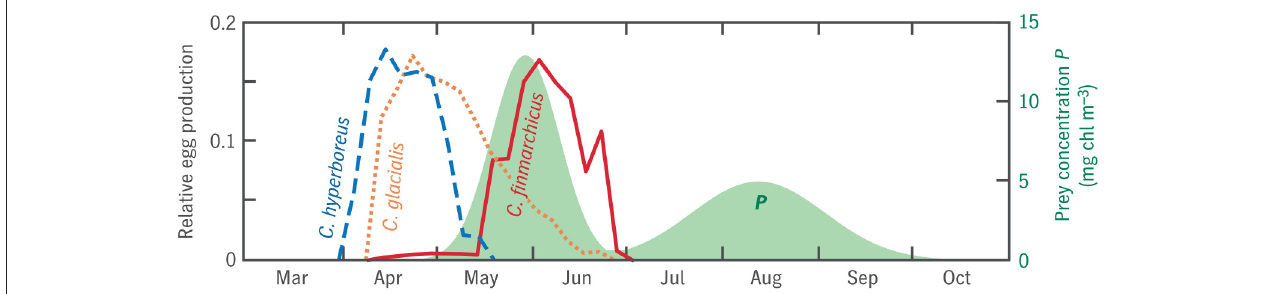
FIGURE 11 | Seasonal progression of egg production in model analogs for three Calanus spp. in Disko Bay (lines), in relation to prey concentration P (shaded). Egg production time series consist of n ( t 0 ), the first eigenvector of the transition matrix V discussed in Section 2.4.3, normalized to integrate to 1.